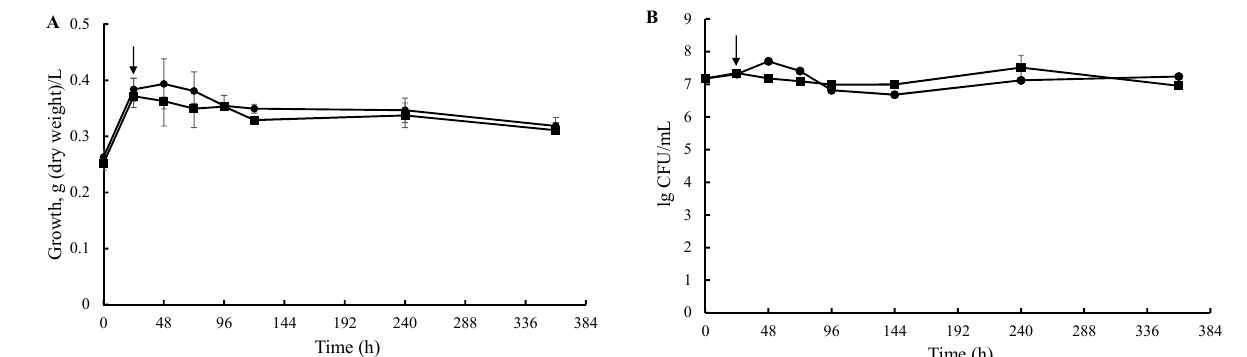
Figure 2. Culture growth in a mineral medium with cholesterol as the only carbon and energy source. ( A ) Biomass of S. hirsuta in a mineral medium in the presence of cholesterol (1.5 mM) (squares) or without steroid (circles, control) measured by dry weight; ( B ) CFU count in the dynamics of incubation of S. hirsuta in a mineral medium in the presence of cholesterol (1.5 mM) (squares) or without steroid (circles). Arrows indicate the addition of cholesterol.